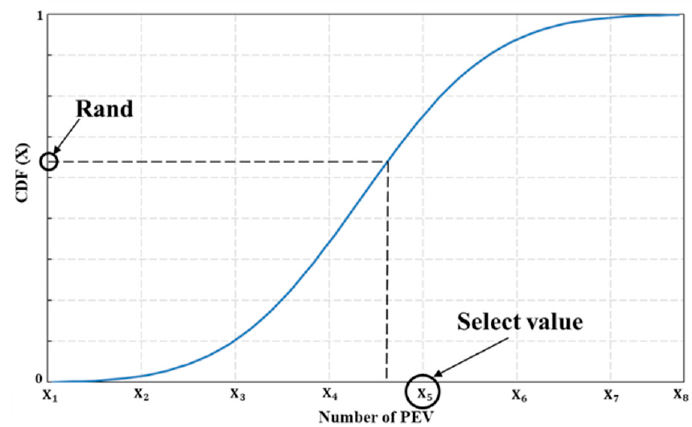
Figure 2. Stochastic method to model the number of PEVs for a household.